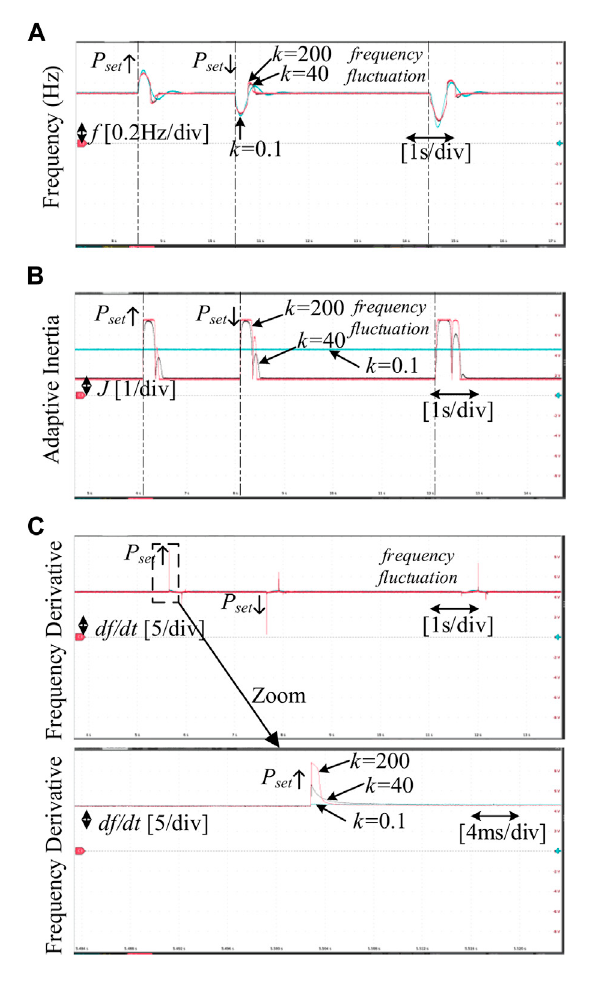
FIGURE 9 The proposed strategy with different K (A) Frequency of